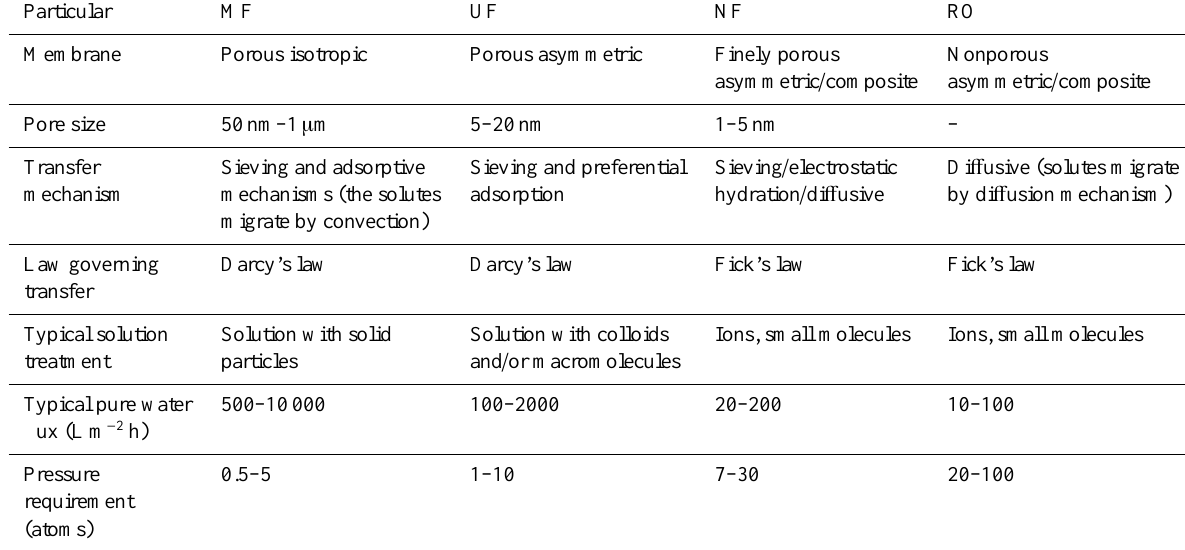
Table 1. Di ff erence between MF, UF, NF, and RO.